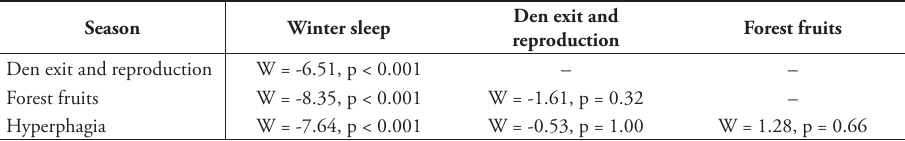
Table 4. Comparison of seasonal altitude of brown bears GPS fixes in Eastern Romanian Carpathians and Subcarpathians (Dunn test with Bonferroni adjustment, α = 0.05). Den exit and Season Winter sleep Forest fruits reproduction Den exit and reproduction W = 0.51, p = 1.00 – – Forest fruits W = -1.61, p = 0.32 W = -2.17, p = 0.09 – Hyperphagia W = 11.40, p < 0.001 W = 11.39, p < 0.001 W = 13.99, p = < 0.001